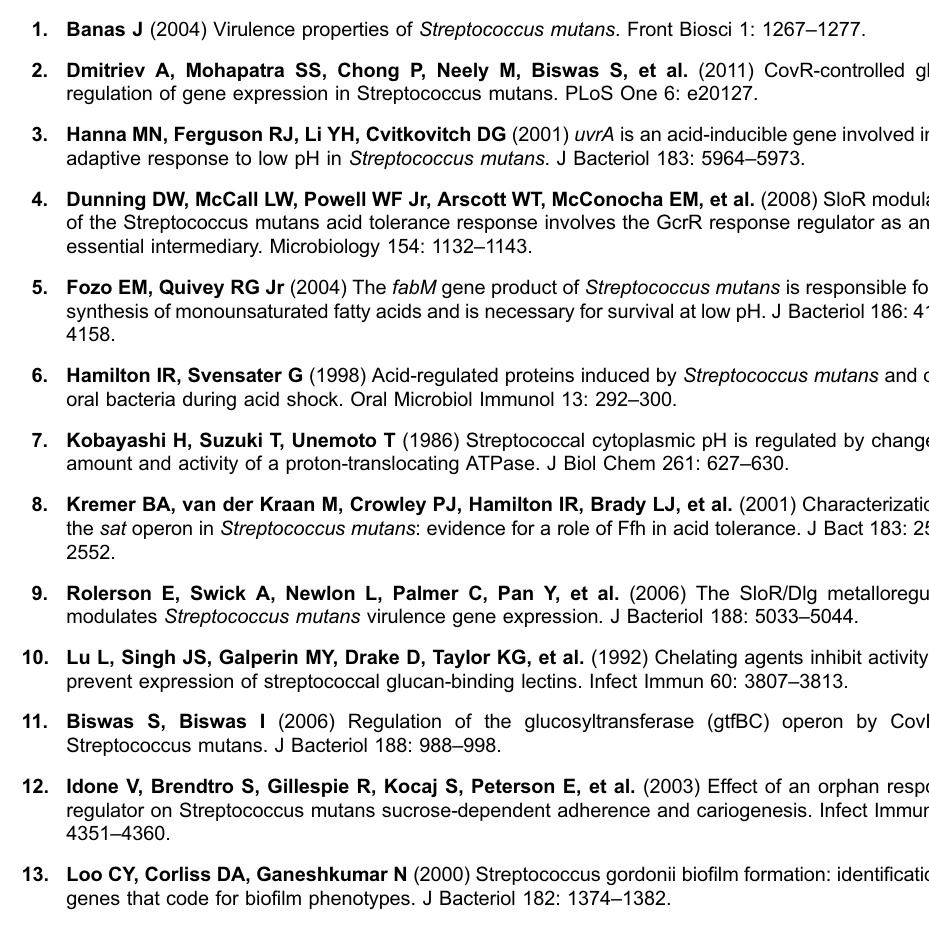
S2 Table. Differences in ATR gene expression in Smuvick compared to